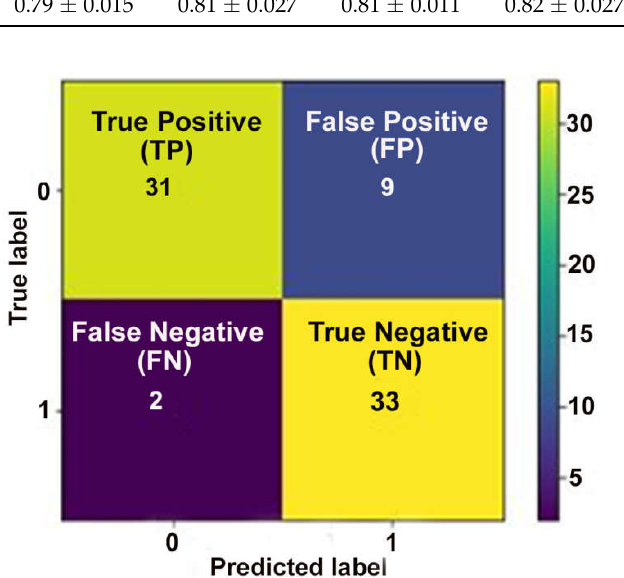
Figure 6. Confusion matrix of the RF-based COVID-19 mortality prediction model was tested on the 20% independent test dataset.